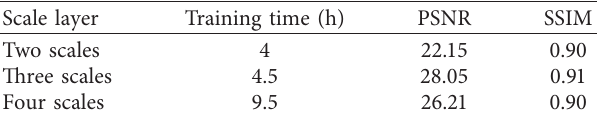
Table 4: Performance comparison of our method with different